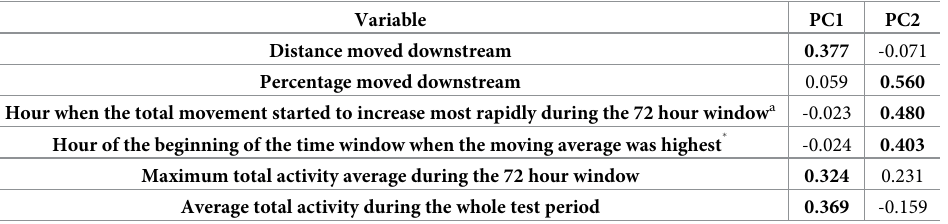
Table 4. Principal components extracted from PCA and migration variables included in the analysis (varimax- rotated component matrix). Three highest loadings per PC are bolded. Variable Distance moved downstream Percentage moved downstream Hour when the total movement started to increase most rapidly during the 72 hour window a -0.023 Hour of the beginning of the time window when the moving average was highest � -0.024 Maximum total activity average during the 72 hour window Average total activity during the whole test period Principal component loadings for different migration variables. a Ln(X+1) transformation